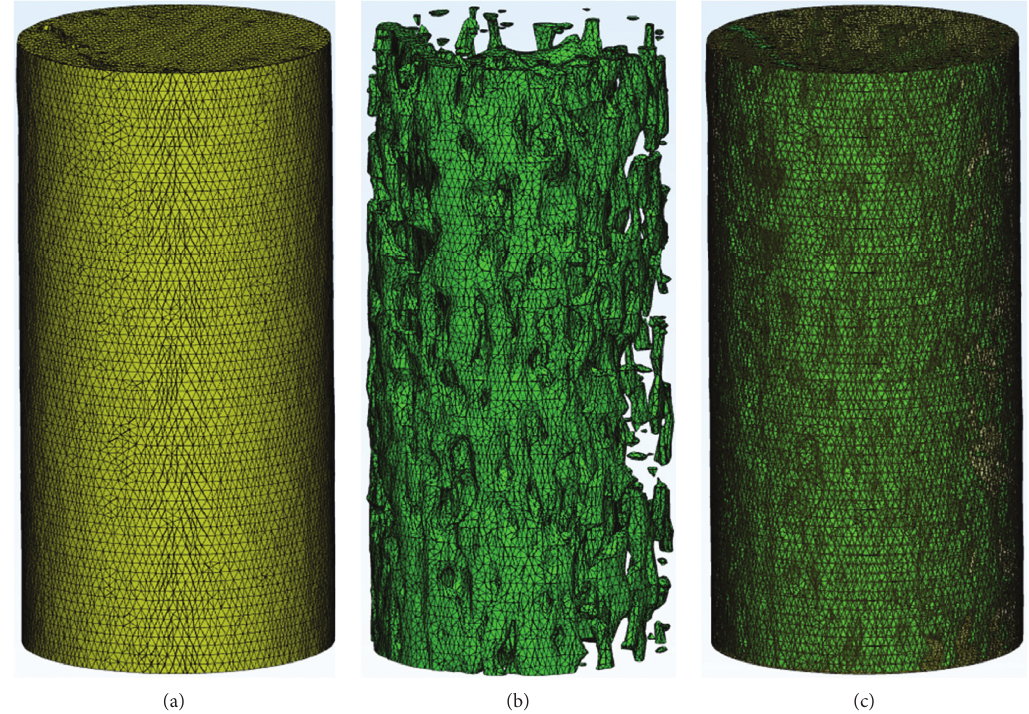
Figure 9: Finite element mesh model of acid-corroded sandstone. (a) Corrosion zone. (b) Uncorroded zone. (c) Rock sample as a